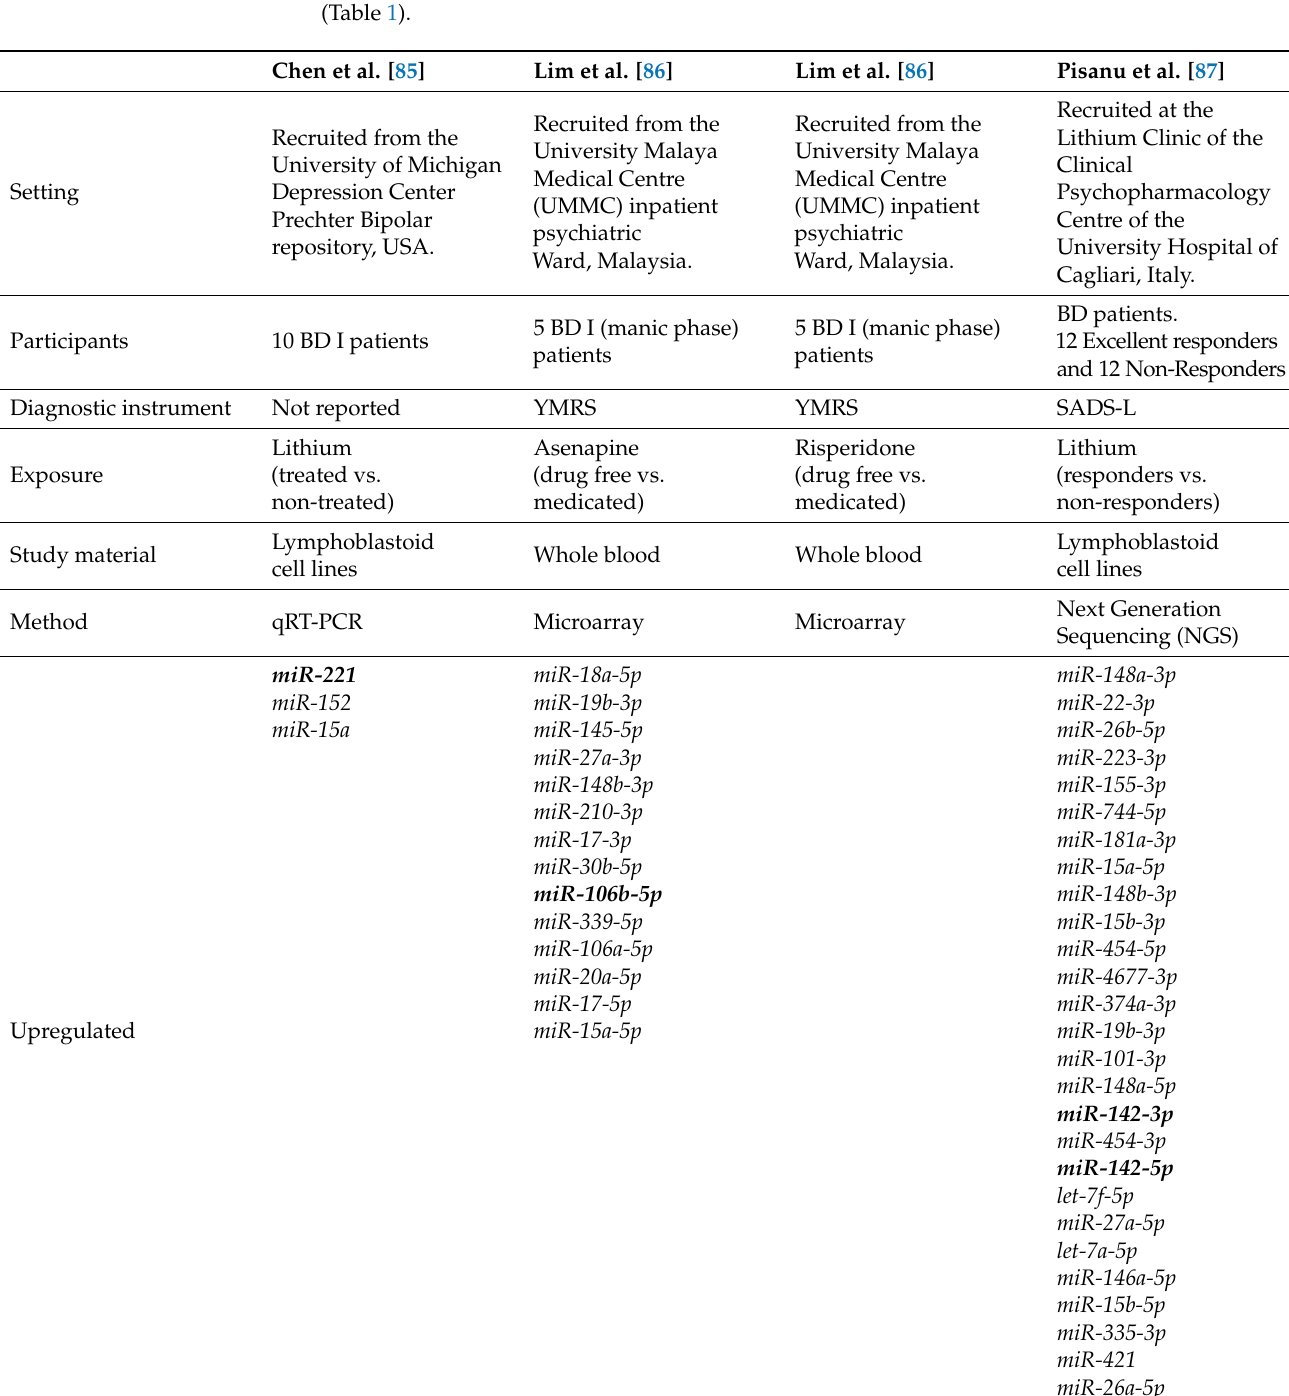
Table 2. Exposome-associated differentially abundant peripheral circulatory miRNAs in blood/blood cells from BP patients. Combined list of miRNAs with significantly altered abundance in BD patients ( p -value < 0.05) after correction for multiple testing. Comparisons include treated vs. non-treated; drug-free vs. medicated; responders vs. non-responders; before treatment vs. after treatment. miRNAs in bold are further reported differentially abundant in BD patients vs. healthy controls (Table